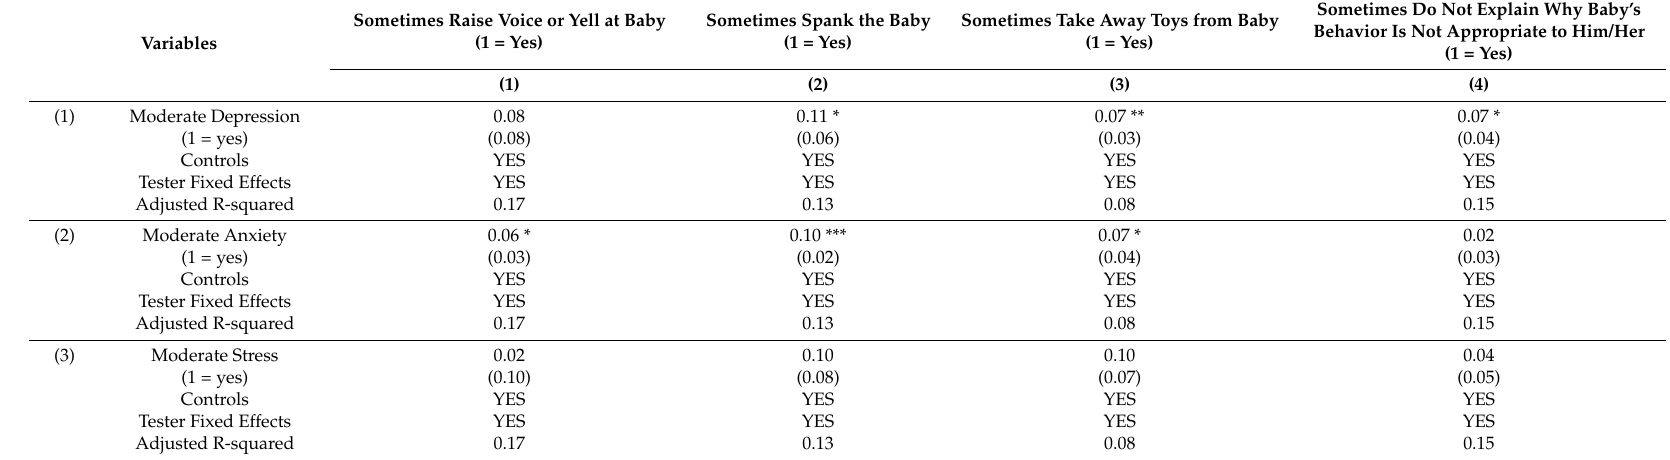
Table 8. Correlations between caregiver’s mental health and negative parenting practices using ordinary least squares, n = 2514. Sometimes Do Not Explain Why Baby’s Sometimes Raise Voice or Yell at Baby Sometimes Spank the Baby Sometimes Take Away Toys from Baby Behavior Is Not Appropriate to Him/Her (1 = Yes) (1 = Yes) (1 = Yes) Variables (1 =